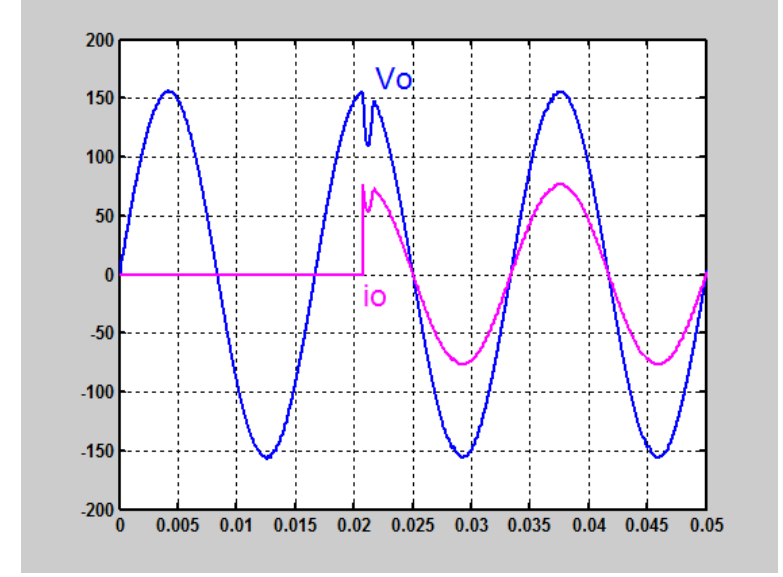
Figure 5. Simulated waveforms in response to the load suddenly turn on for the classic FTCC (50 V/div 10 A/div).